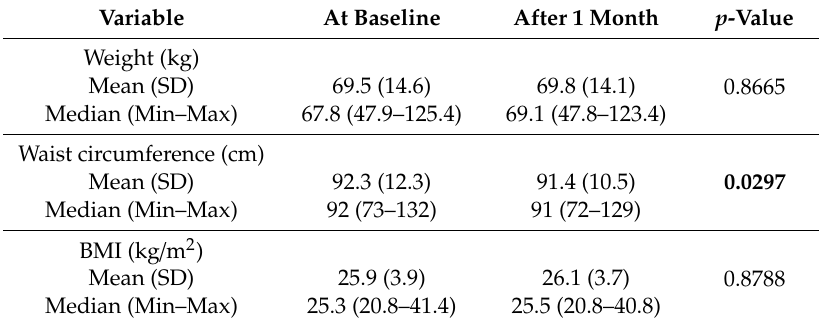
Table2. ChangesofbiometricparametersafterfourweeksofdietaryinterventionwithOFI-supplemented pasta in all patients. In bold are the p -values that reached statistical significance.